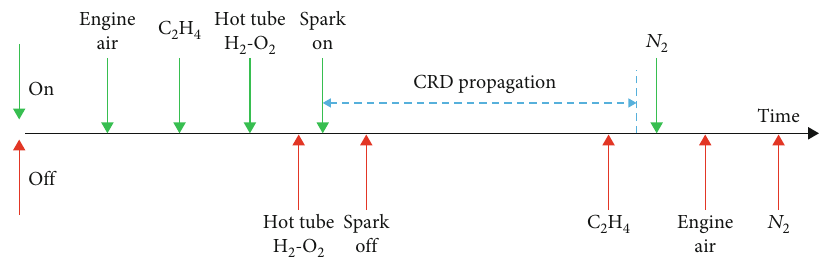
Figure 2: Time sequence of experimental tests.